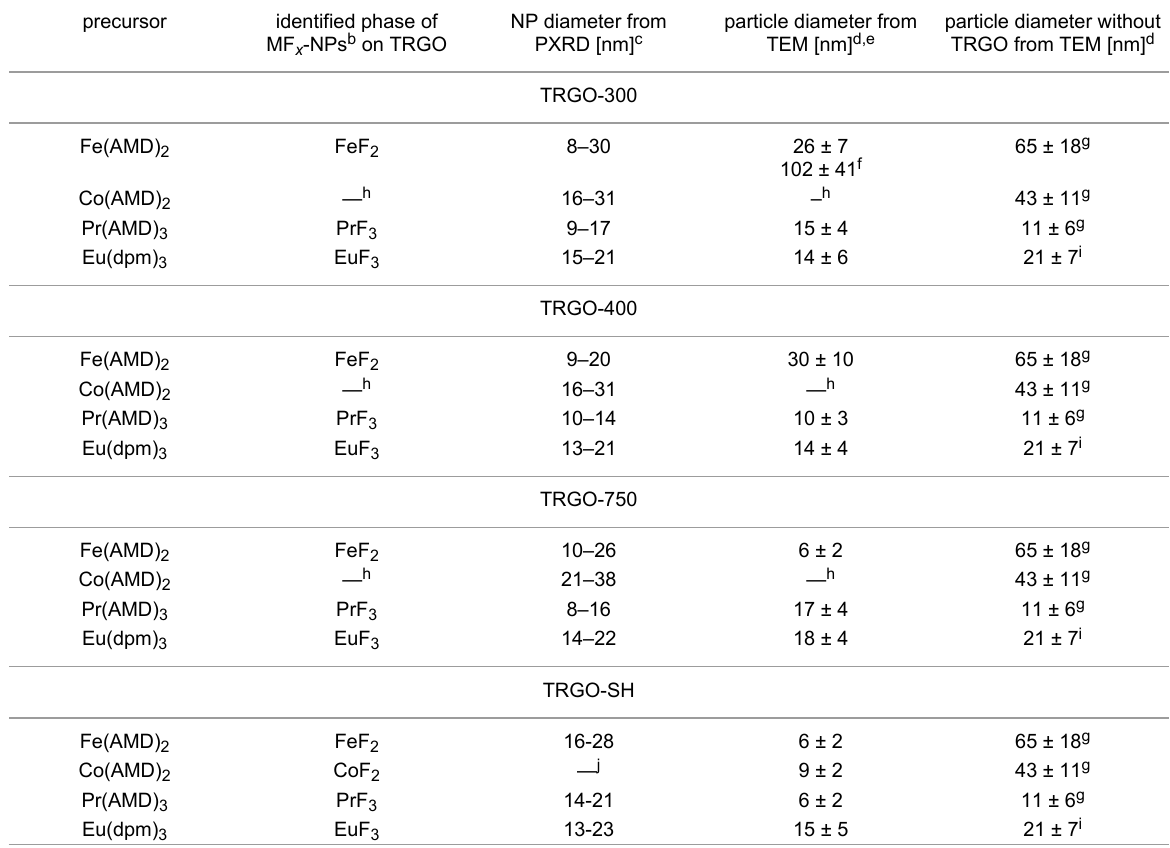
Table 1: Determined sizes of MF x -NPs in MF x @TRGO samples. a